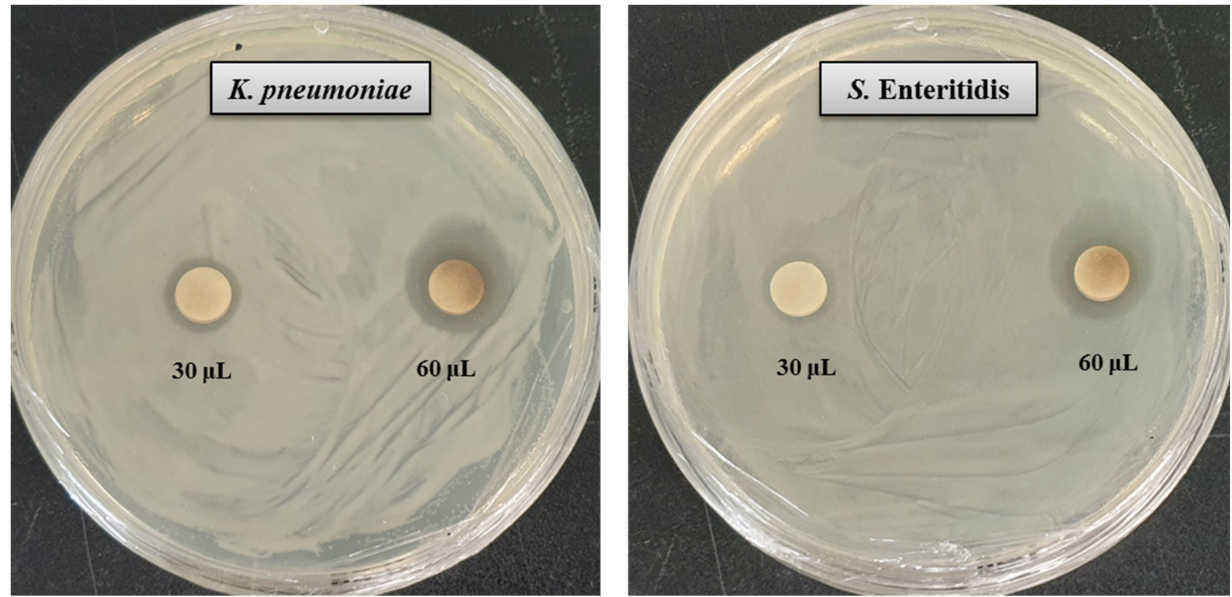
Figure 5. Zones of inhibition of biosynthesized AgNPs (30 µ L and 60 µ L at 1000 ppm concentrations in water) against K. pneumoniae and S. Enteritidis.